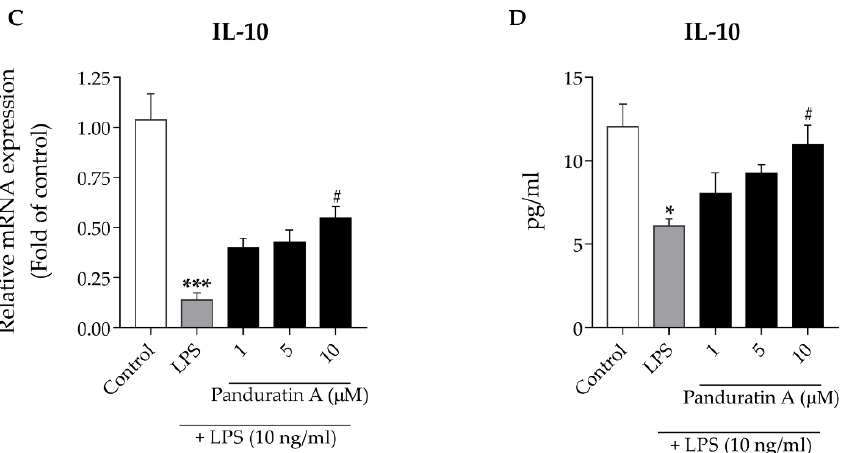
Figure 4. Effect of panduratin A on IL-4 and IL-10 production against LPS stimulation. Panduratin A increased mRNA expression of ( A ) IL-4; ( C ) IL-10. Panduratin A enhanced cytokine release of ( B ) IL-4; ( D ) IL-10. The control was DMSO treatment. * p < 0.05, ** p < 0.01, and *** p < 0.001 compared to control; # p < 0.05 compared to LPS-treated cells (one-way ANOVA followed by Tukey’s test).